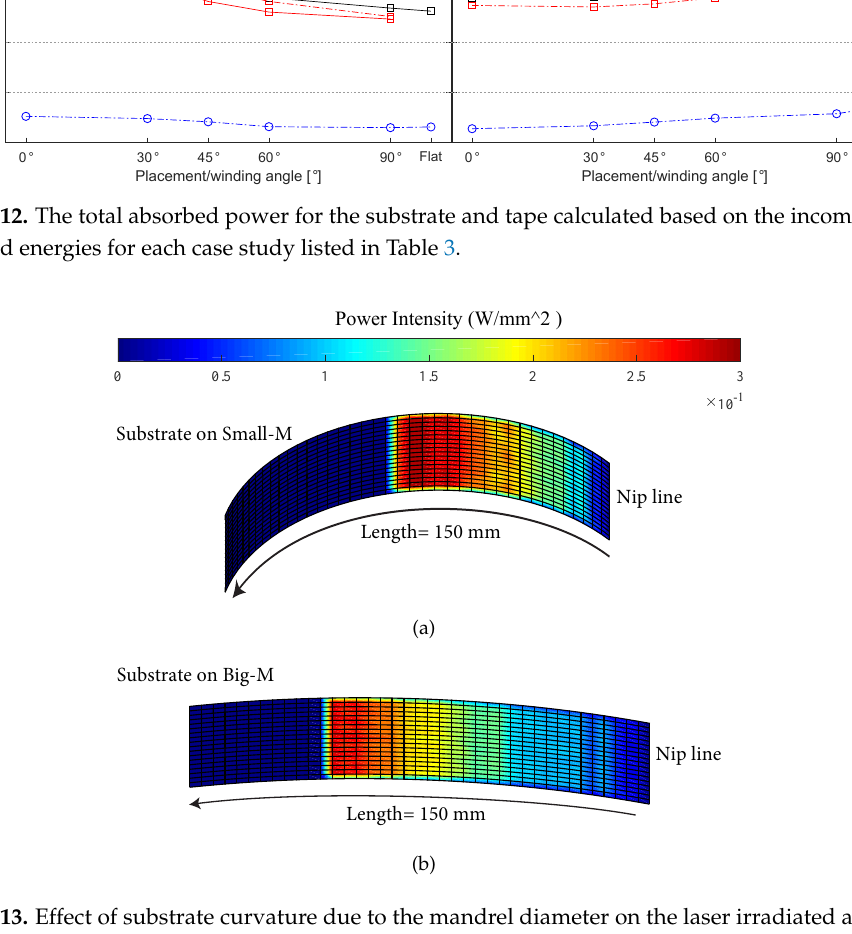
Figure 13. Effect of substrate curvature due to the mandrel diameter on the laser irradiated area and its absorbed power intensity on the case Ref-0 ◦ for: ( a ) Small-M, ( b ) Big-M (For interpretation of the references to color in this figure legend, the reader is referred to the web version of this